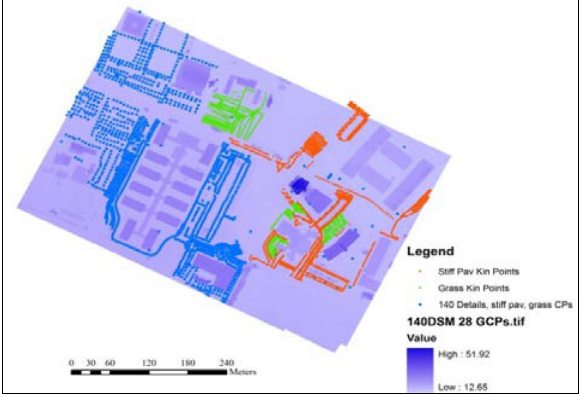
Figure 6 – DSM of flight at 140 m and GPS survey points